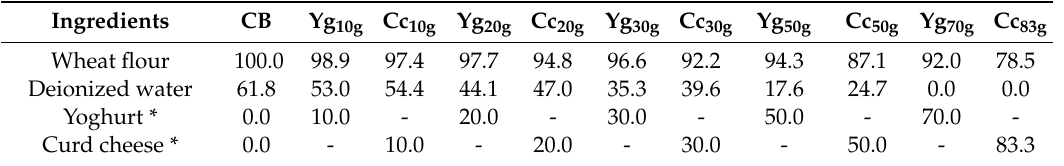
Table 1. Bread formulations optimized to the control bread (CB) and di ff erent levels of yoghurt (Yg) and curd cheese (Cc) addition, considering the moisture content and dry extract of each dairy product (DP) *. Ingredients CB Yg 10g Cc 10g Yg 20g Cc 20g Yg 30g Cc 30g Yg 50g Cc 50g Yg 70g Cc 83g Wheat flour 100.0 98.9 97.4 Deionized water Curd cheese * 0.0 10.0 * 100 g of Yg: moisture—88.5 g; dry extract—11.5 g; * 100 g of Cc: moisture: 74.2 g; dry extract: 25.8